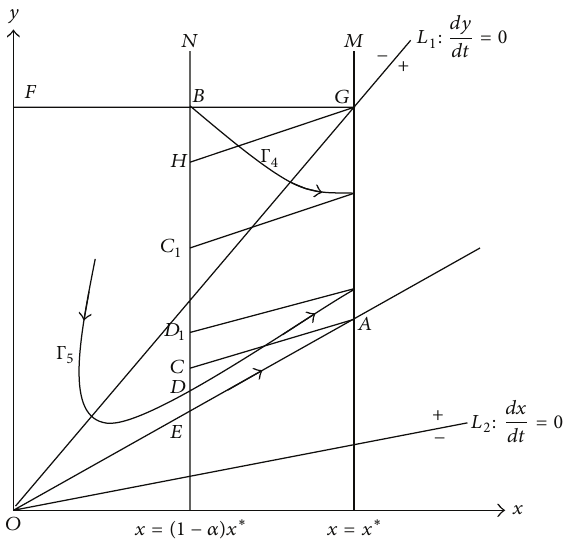
Figure 7: The order-1 periodic solution Γ of system (1) is stable. such that lim 𝑡→∞ 𝑡 𝑛 = +∞ . If 𝑄 is the limit point of point range {𝑓(𝑃, 𝑡 𝑛 )}, 𝑛 = 1 , 2 , . . . , One calls 𝑄 the 𝜔 limit point of point range {𝑓(𝑃, 𝑡 𝑛 )}, 𝑛 = 1 , 2 , . . . . The set Ω made up of all limit points of point range {𝑓(𝑃, 𝑡 𝑛 )}, 𝑛 = 1 , 2 , . . . , is called